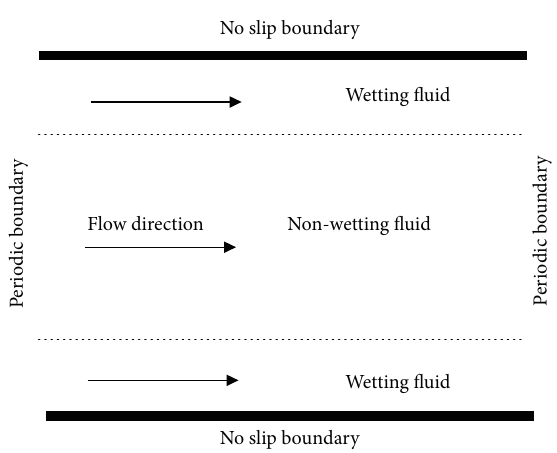
Figure 6: Schematic of 2D immiscible two-phase Poiseuille fl ow.